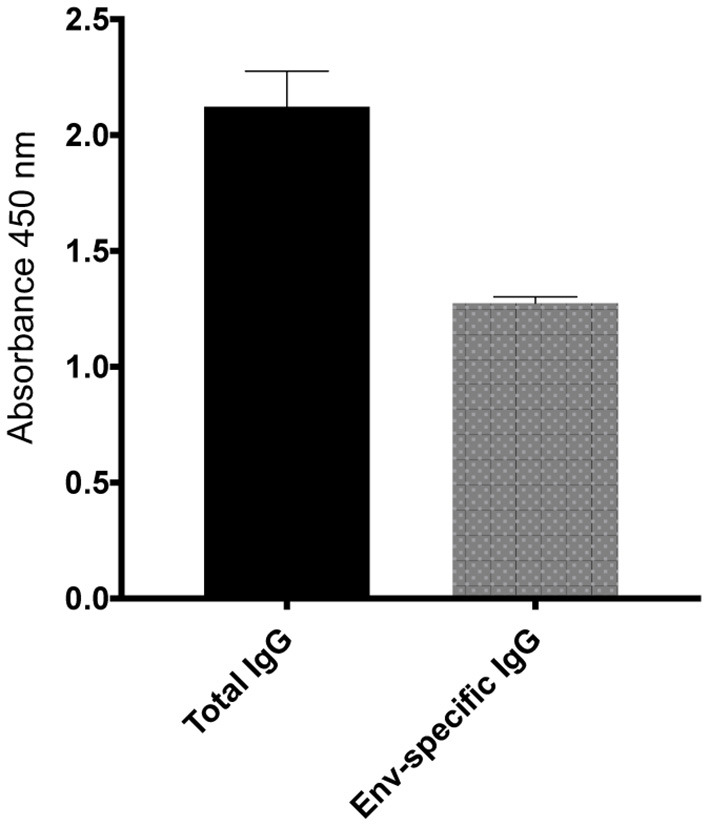
Total and Env-specific binding Abs present in the purified total Ig isolated from the Mamu-B*17+ RMs at 1 μg/ml. At a normalized concentration of 1 μg/ml, a large proportion of Abs present in the purified total IgG bound to SIVmac239 gp140 protein. The purified total Ig had no neutralization activity against SIVmac239 (data not shown).